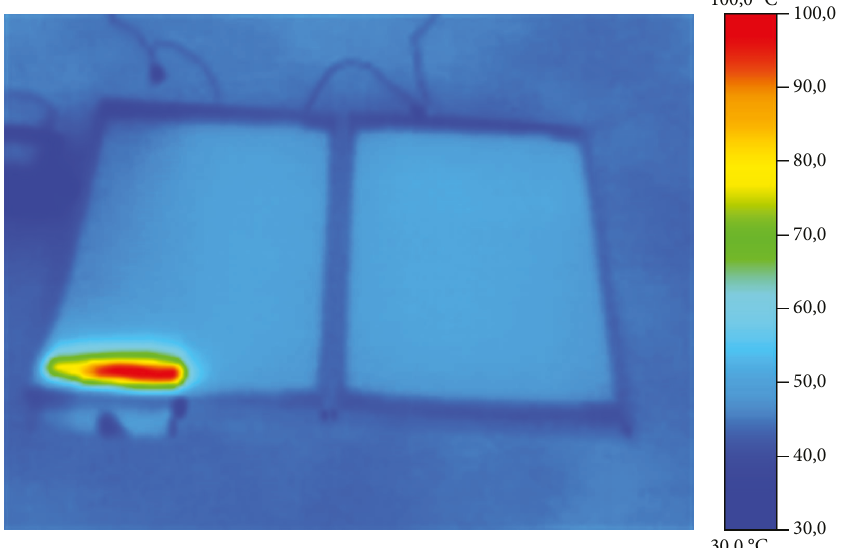
V = 16 V , MPP). 26 September 2017, Aversa (CE), Italy. 2 ( PV = 25 ° C amb